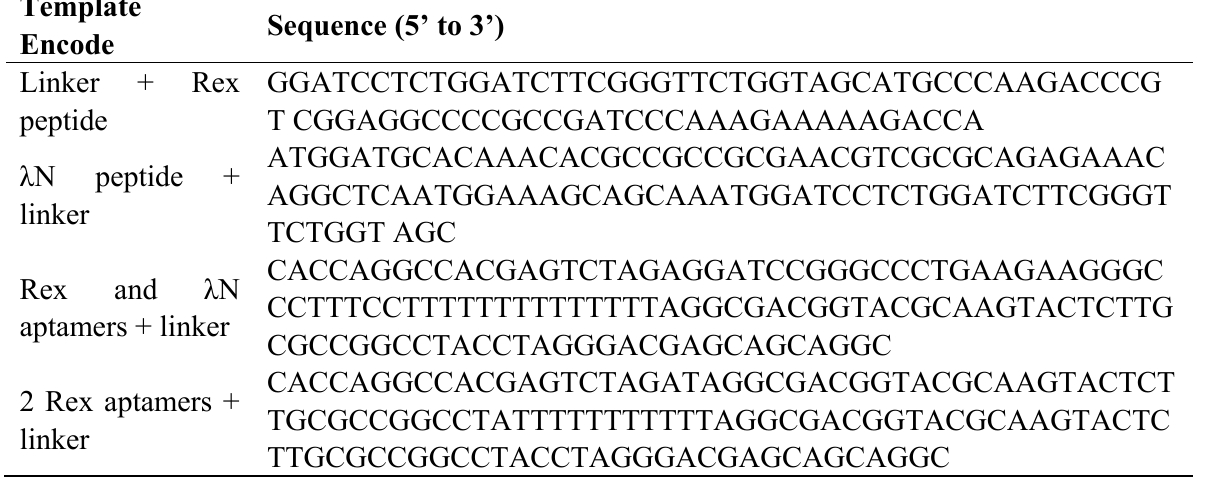
Table 1s. DNA templates used in this study for PCR